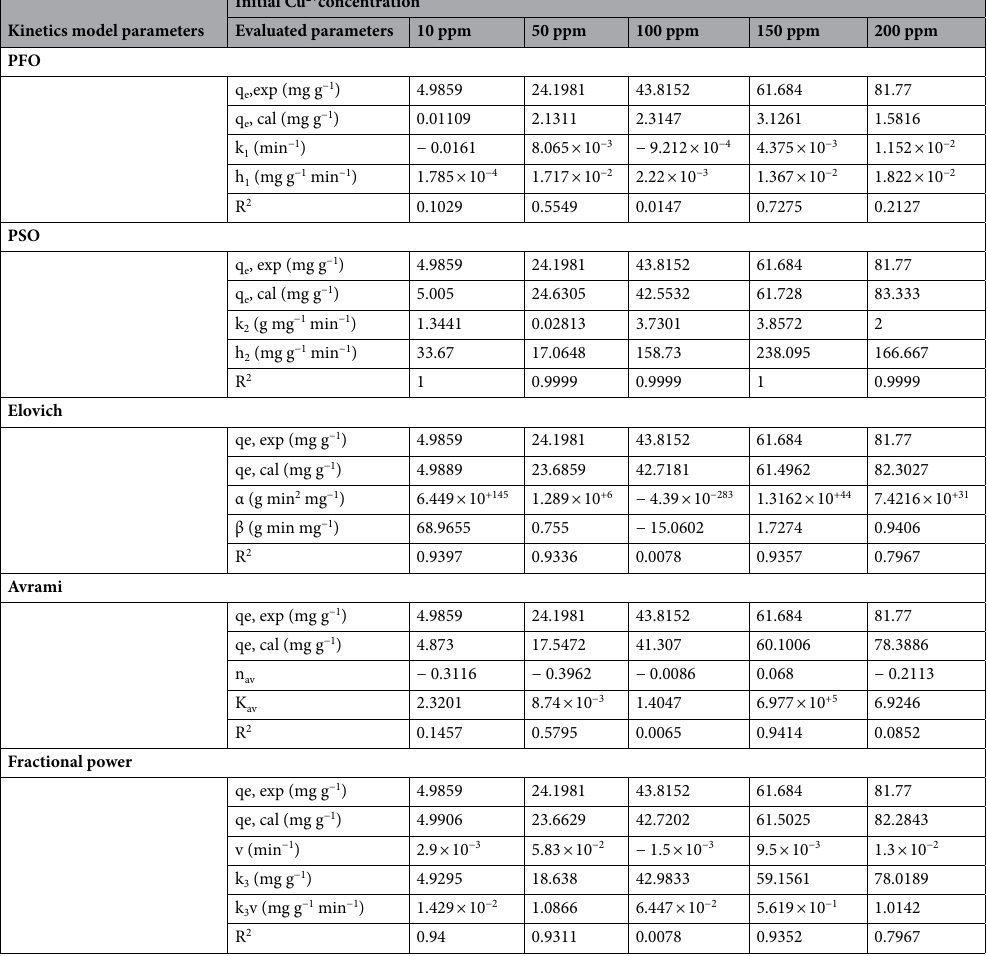
Table 5. Kinetic data for adsorption of Cu 2+ onto nZVI at different initial concentrations.